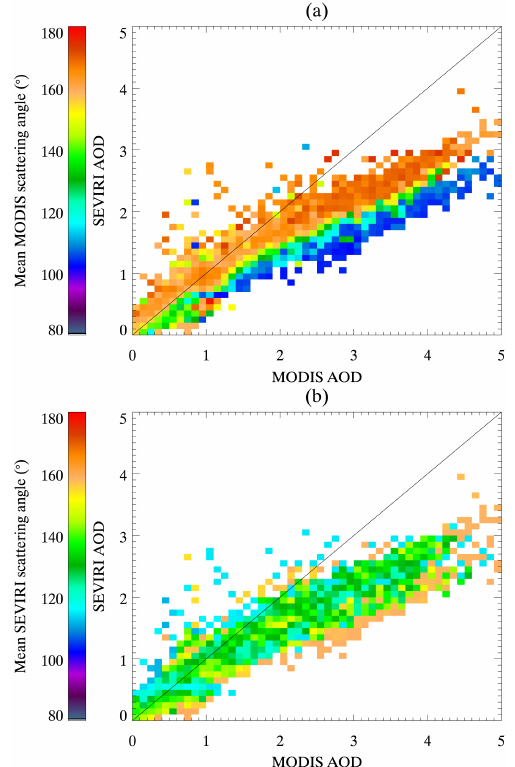
Figure 10. MODIS AOD against SEVIRI AOD over the Red Sea during April (2005–2015) colour coded by (a) mean MODIS scat- tering angle and (b) mean SEVIRI scattering